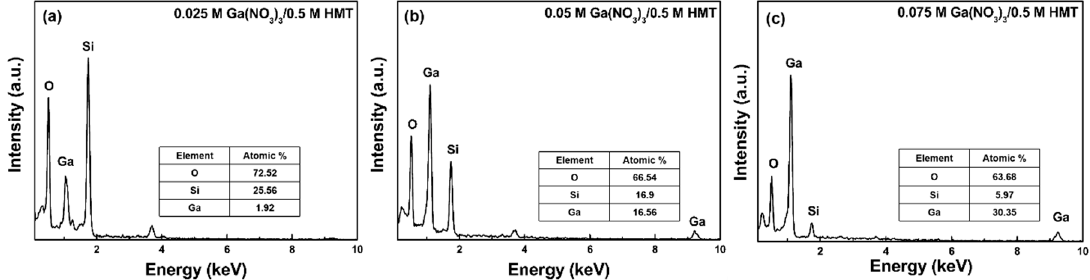
Figure 6. EDS spectra of annealed samples synthesized using ( a ) 0.025 M Ga(NO 3 ) 3 , ( b ) 0.05 M Ga(NO 3 ) 3 and ( c ) 0.075 M Ga(NO 3 ) 3 . The samples were annealed for 3 h at 500 °C.